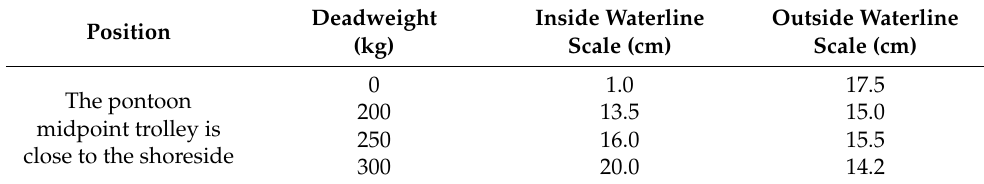
The draft relation curve between eccentric load and position is shown in Figure